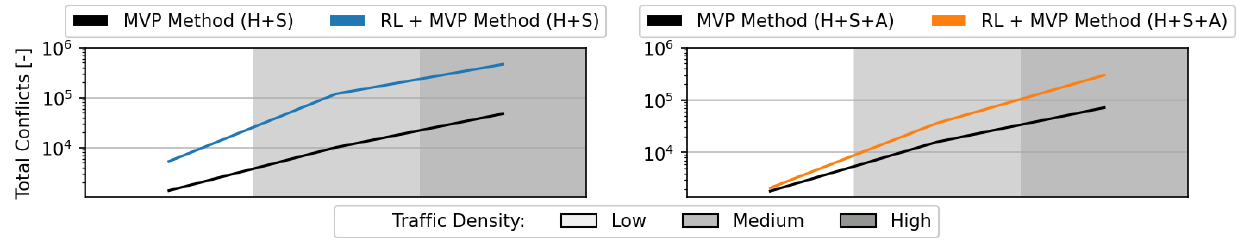
Figure 12. Mean total number of pairwise conflicts during testing of the RL